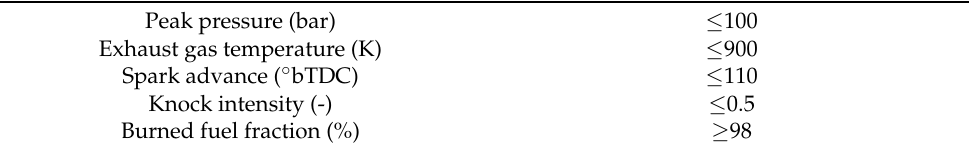
Table 4. Operating